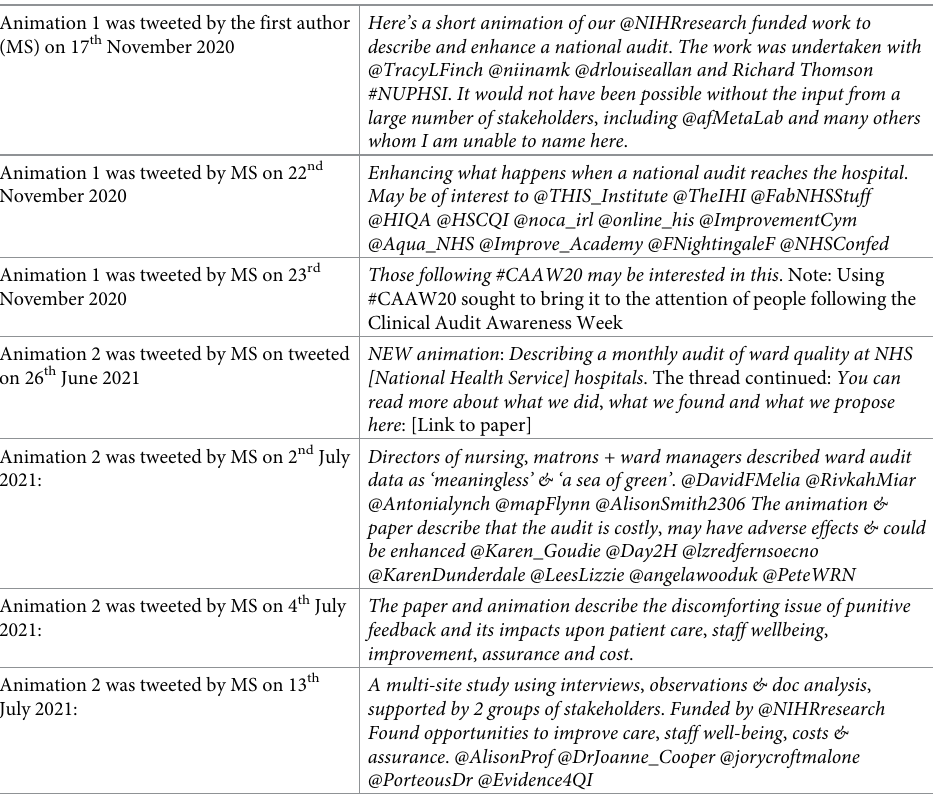
Table 1. The source, date and content of the Tweets delivering the